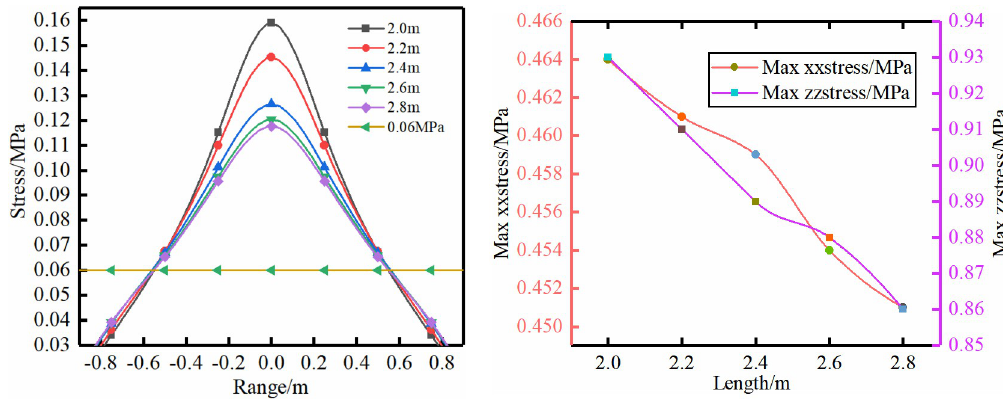
Fig 7. Different bolt